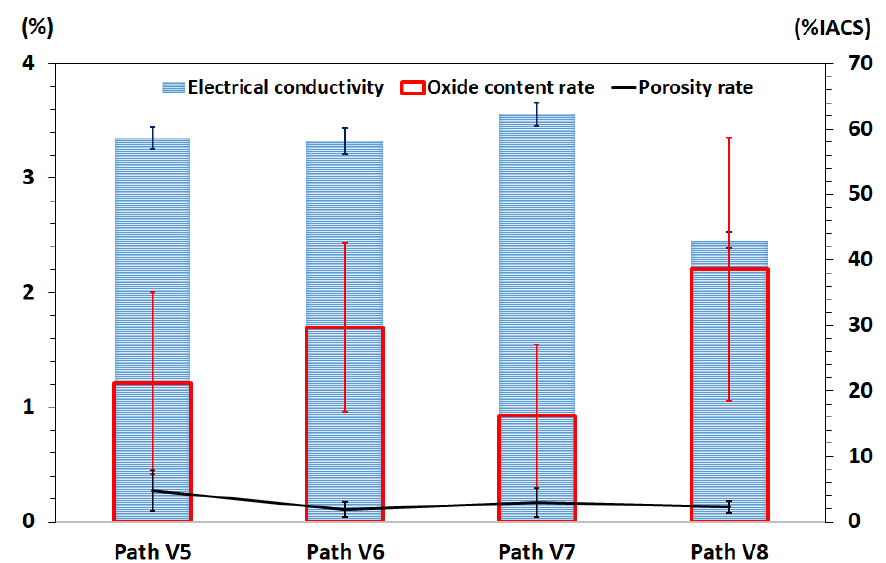
Figure 6. Electrical conductivity, porosity rate and oxide content of the Cu coating produced by the paths V5, V6, V7 and V8.